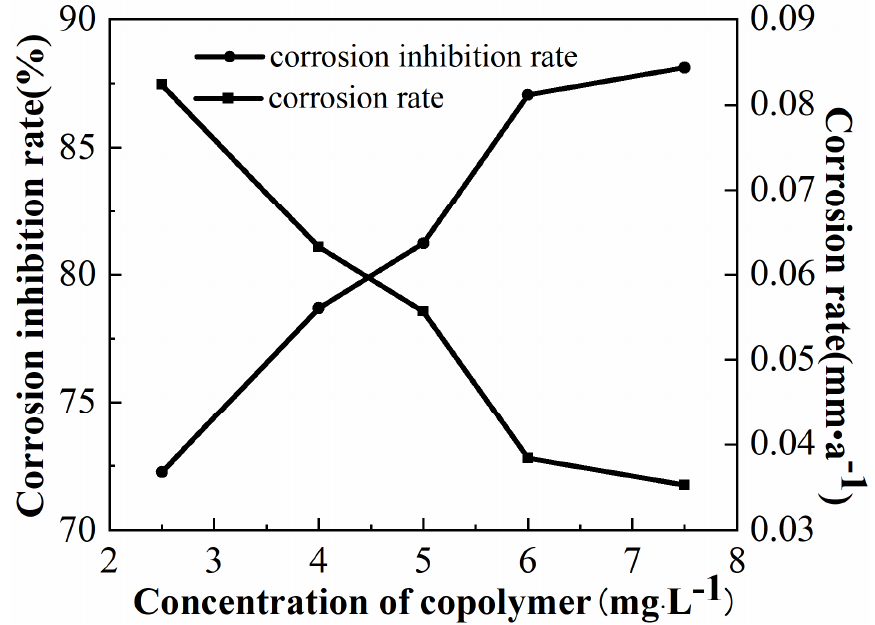
Figure 7. Influence of copolymer dosage on corrosion inhibition performance .